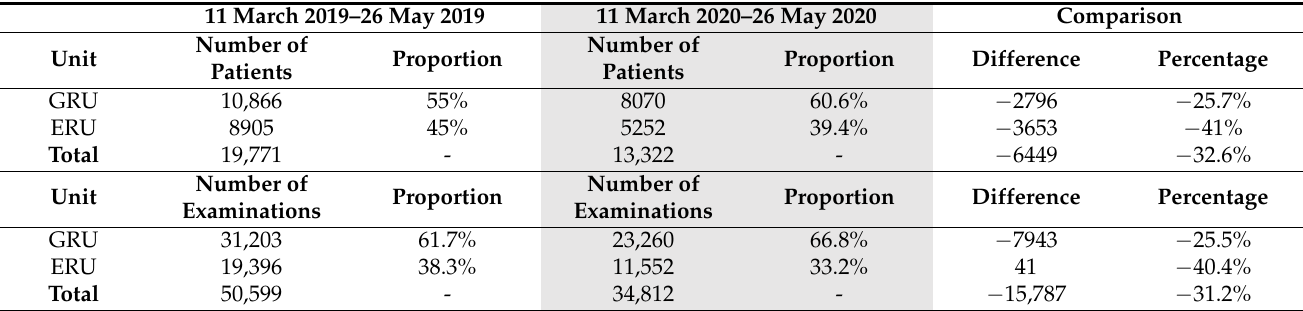
Table 1. Number of patients assisted and diagnostic investigations performed during the ordinary 2020) in the radiology department of our institution; data are sorted relatively to the GRU and the ERU, and it is reported the proportion of examinations performed and patients assisted by each unit. The comparisons between the two-time intervals are expressed in absolute numbers and percentage